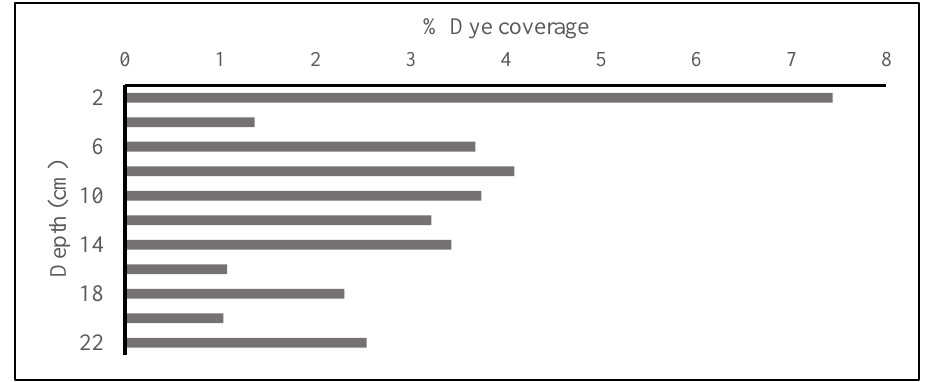
Figure 7. ( a – d ) Soil moisture variations at experimental hillslope plot.